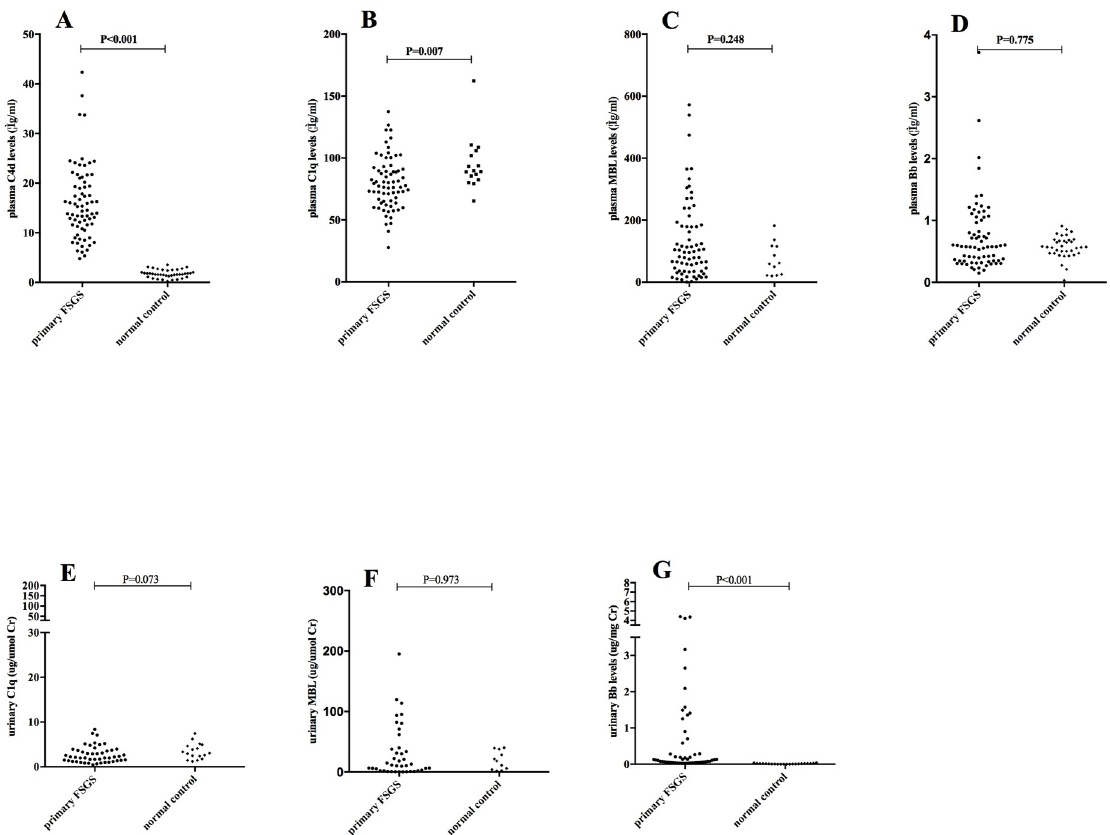
Fig 2. Plasma and urinary C4d, Bb, C1q and MBL levels between patients with primary FSGS and normal subjects. The plasma C4d level was significantly increased, the plasma C1q level was significantly decreased, and the urinary Bb was significantly increased in FSGS.